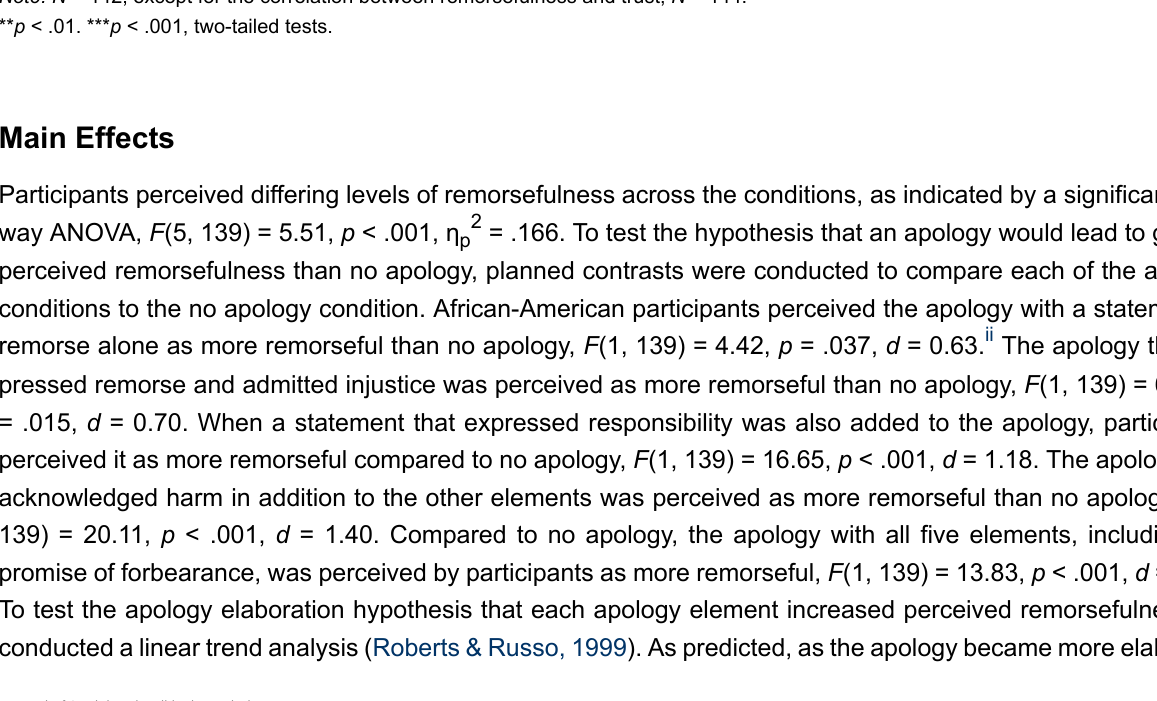
Correlations ForgivenessTrustJustice Norms Remorsefulness .05.07.51*** Justice Norms .13.23** Trust